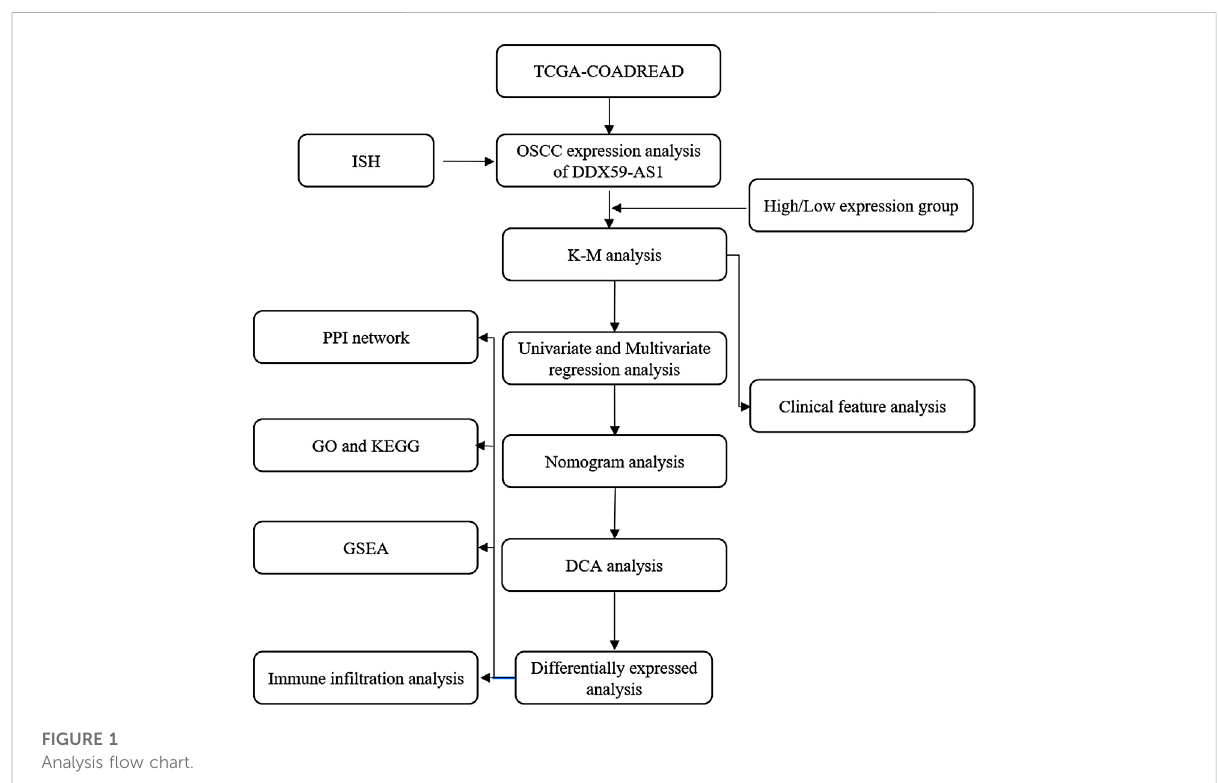
FIGURE 1 Analysis fl ow